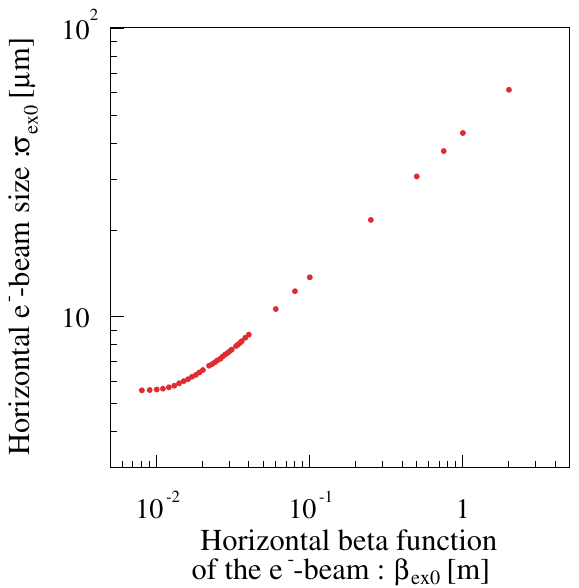
FIG. 5. (Color) Simulated horizontal e (cid:1) -beam size as a func- tion of the horizontal beta function using SAD .